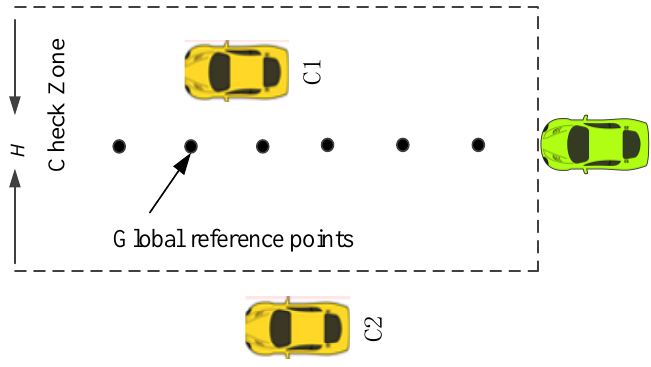
Figure 7. Check zone in unstructured driving.